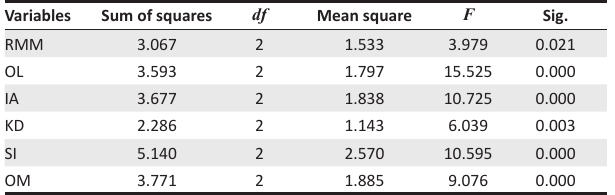
assumptions underlying the maximum likelihood estimation which is more oriented towards predictive applications (Jöreskog & Wold 1982). For estimation, PLS uses least square estimation and attempts to maximise the variance explained by constructs and parameter estimates by minimising each residual variance separately for improved prediction of